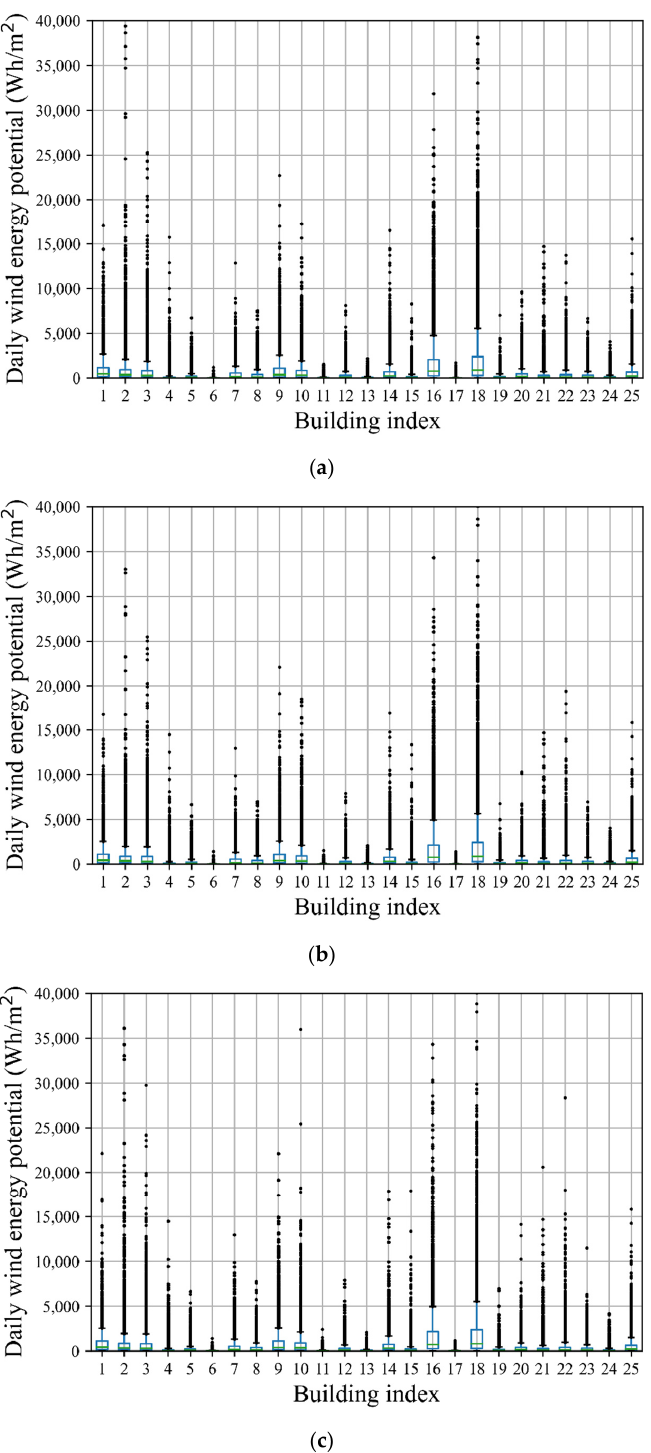
Figure 10. Daily wind power potential boxplot of 25 buildings under RCP8.5 and RCP4.5 from 2020 to 2049. ( a ) ∆α = 5° and RCP4.5. ( b ) ∆α = 10° and RCP4.5. ( c ) ∆α = 5° and RCP8.5.